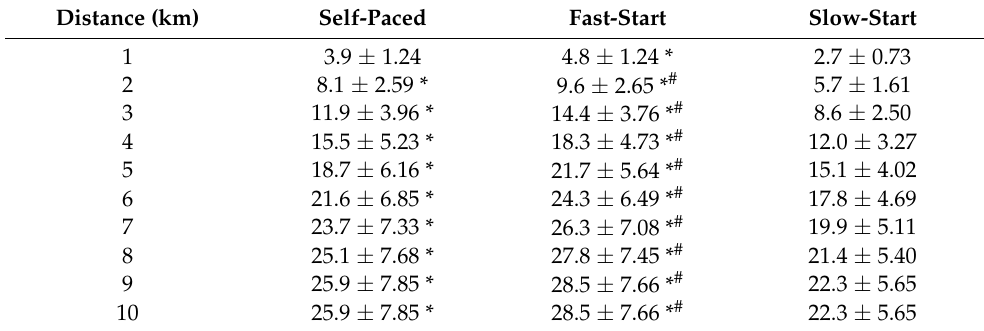
Table 8. Means ± standard deviations of the summated Hazard Score during self-paced, fast-start, and slow-start time